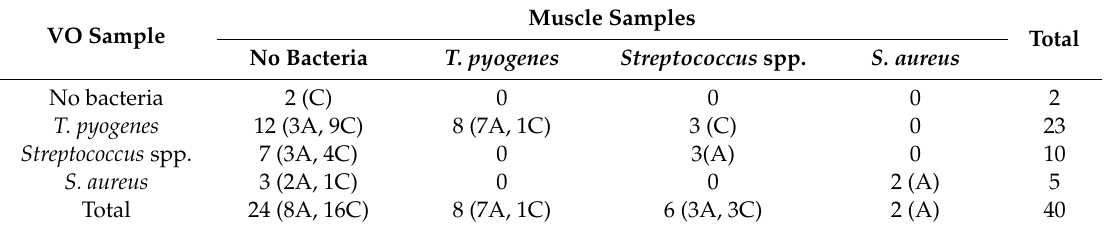
Table 4. Microbiological results from vertebral osteomyelitis (VO) and muscle samples. VO